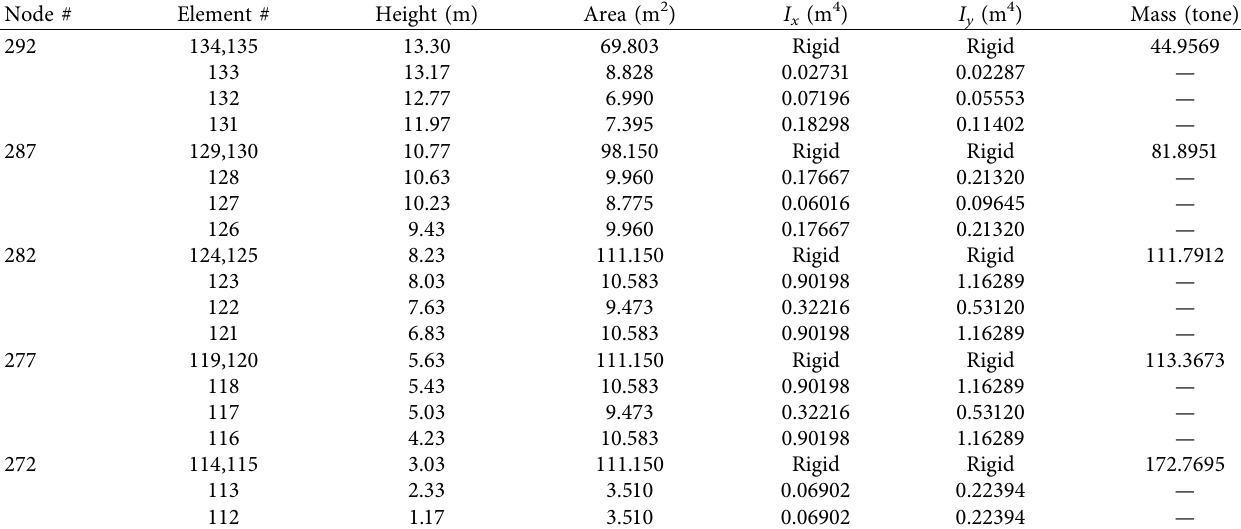
Figure 3: FE analysis models for the objective structure. (a) Building models (full and lumped mass). (b) Lumped mass structure+soil model for the SSI analysis. Table 1: Geometric properties of the lumped mass frame FE model for the SSI